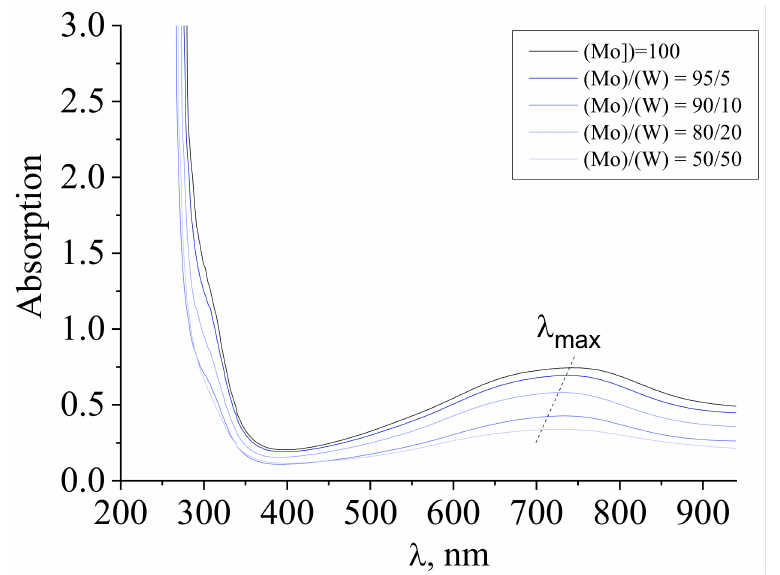
Figure 1. The electronic absorption spectrum of dispersion of molybdenum–tungsten blue synthe- sized using ascorbic acid ((R)/(Mo) = 1) and with different molar ratios